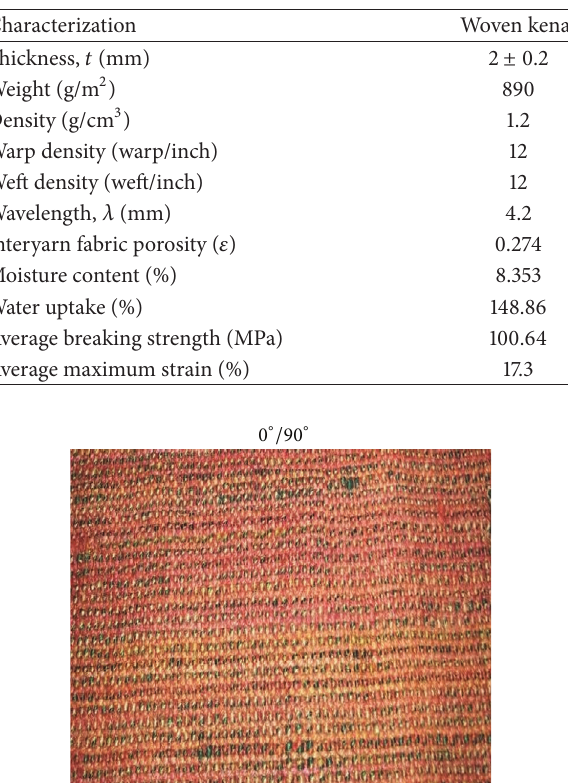
Table 1: Properties of woven kenaf [18].